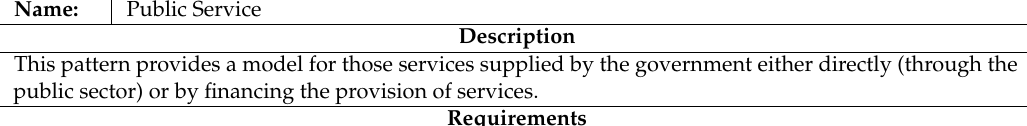
Table 12. Public Service